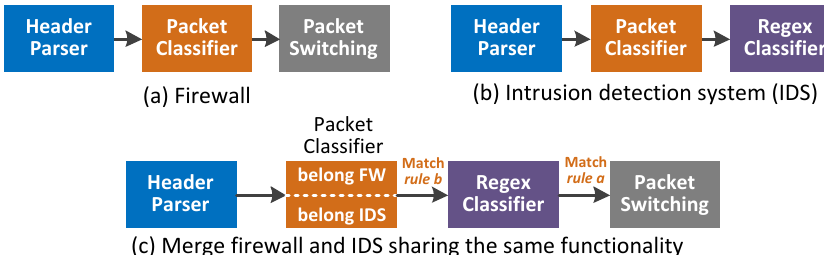
Figure 1. Simple processing pipelines for firewall and IDS. The IDS shares similar functionalities with a firewall while keeping data